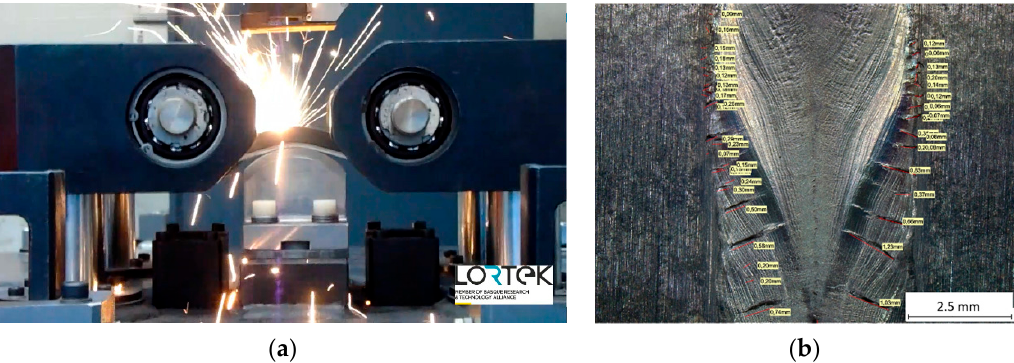
Figure 2. ( a ) LBW Varestraint testing device and ( b ) measurement of total crack lengths (TCL). Labels of individual cracks in fusion zone (FZ) and heat-affected zone (HAZ) are displayed.